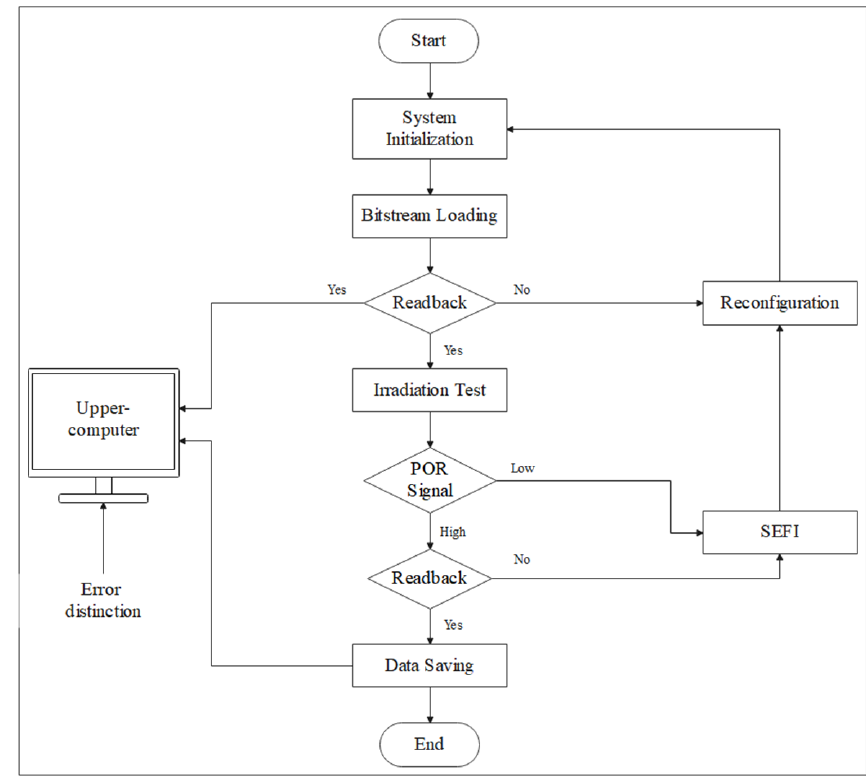
Figure 2. SEE detection process for configuration RAM.